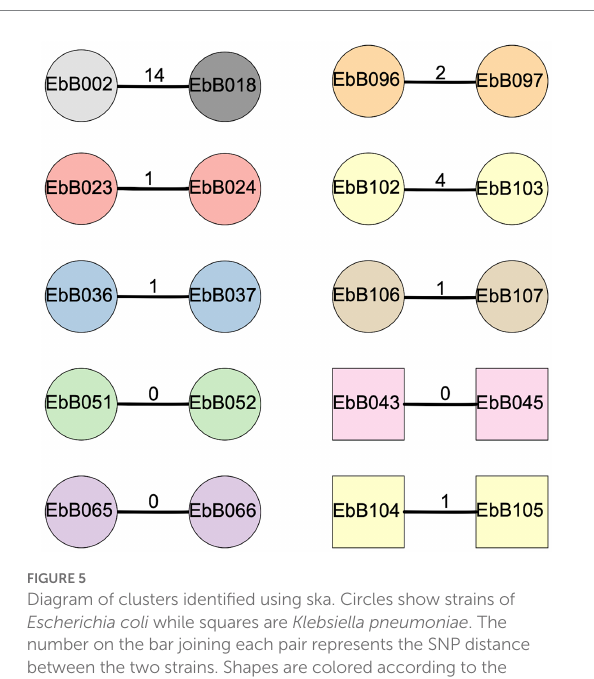
FIGURE 5 Diagram of clusters identified using ska. Circles show strains of Escherichia coli while squares are Klebsiella pneumoniae . The number on the bar joining each pair represents the SNP distance between the two strains. Shapes are colored according to the mother-infant pairs they were isolated from, with gray shapes for strains taken from unpaired